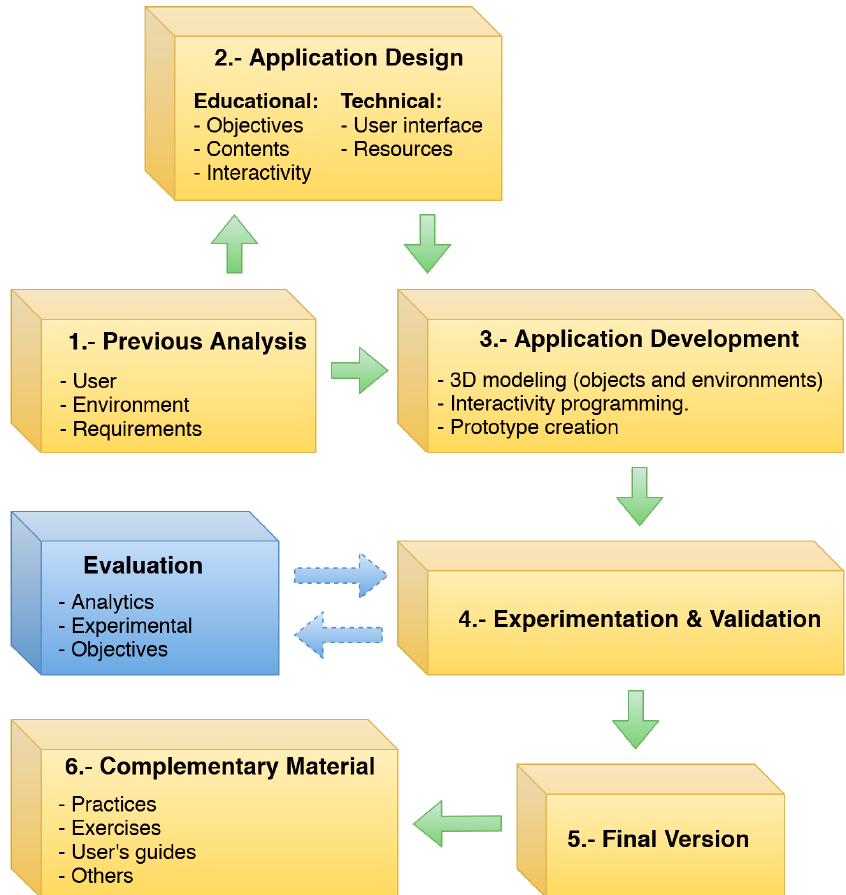
Figure 2. Workflow followed during the VRLEs lifecycle, based on previous works.